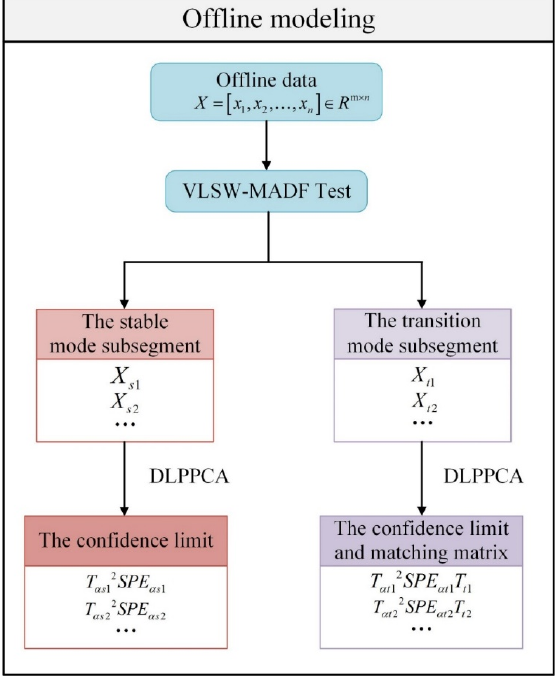
Figure 2. Flowchart of the offline modeling.